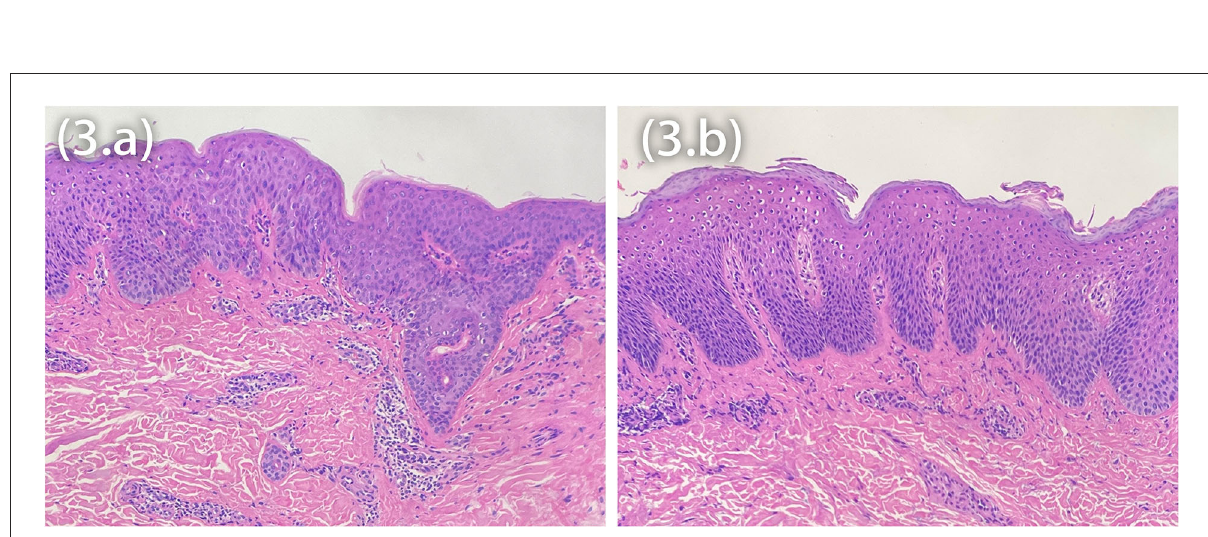
FIGURE3 Histopathology showing acanthosis, ectatic capillaries, perivascular lymphocytes infiltration, and parakeratosis with the absence of the granular cell layer (A,B) , interestingly the absence of